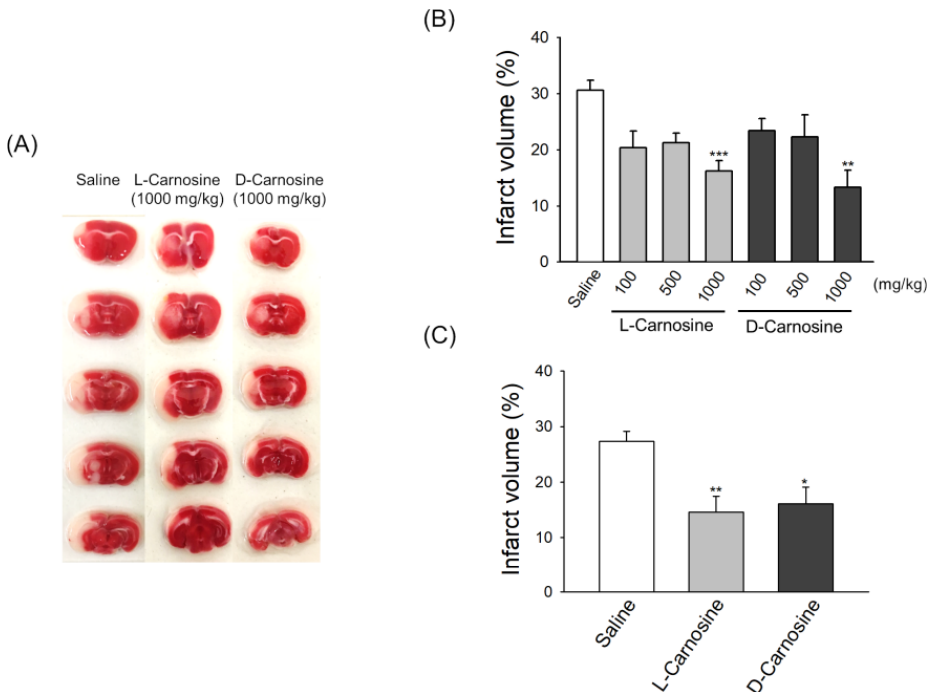
Figure 2. Neuroprotective effects of L - and D -carnosine against ischemic damage in transient focal ischemic mouse model. ( A and B ) Representative images of TTC staining of mouse brain ( A ) and infarct volumes ( B ) after 48 h postintraperitoneal administration of saline, D - or L -carnosine (100 mg/kg ( n = 6), 500 mg/kg ( n = 6) or 1000 mg/kg ( n = 6)) at onset of reperfusion. Mean ± SEM. ** p < 0.01, and *** p < 0.001 vs saline ( n = 7). ( C ) Comparison of infarct volume between intravenously administered saline ( n = 10), L -carnosine ( n = 12; 1000 mg/kg) or D -carnosine ( n = 13; 1000 mg/kg) when delivered at 2 h postischemia. Mean ± SEM. * p < 0.05, and ** p < 0.01.